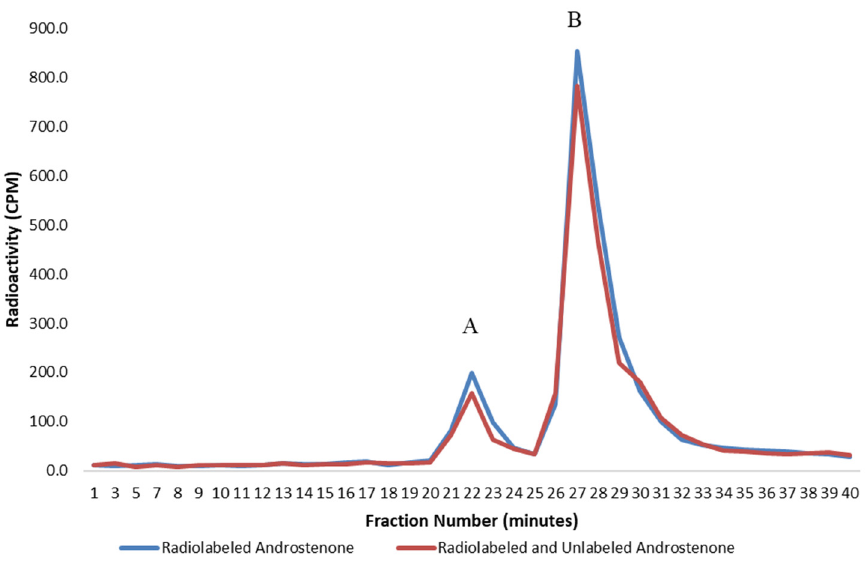
Figure 1. A graph showing the specific binding of radiolabelled androstenone to proteins in porcine plasma determined from the difference in the area under the binding curve, which was quantified from two separate incubations using radiolabeled (blue) or radiolabeled and unlabeled (red) an- drostenone. The bound and unbound peaks are represented by A and B, respectively. Values are expressed as a mean from two separate experiments.